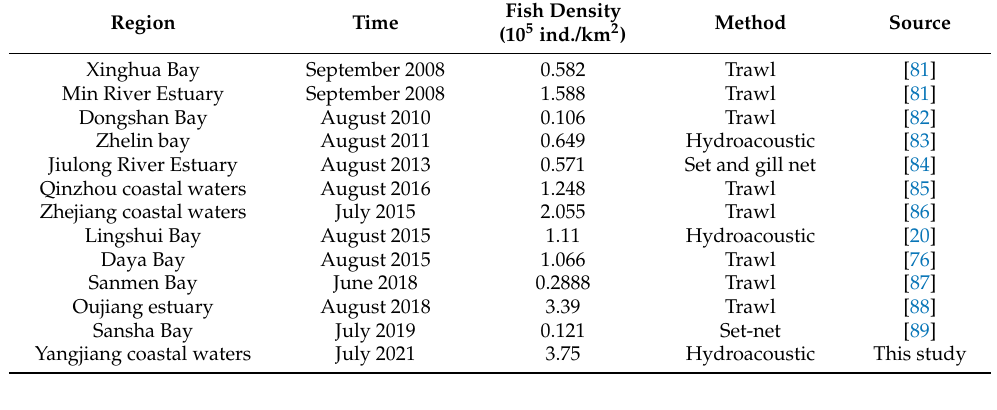
Table 6. Mean fish densities in coastal waters of China in summer. Region Time